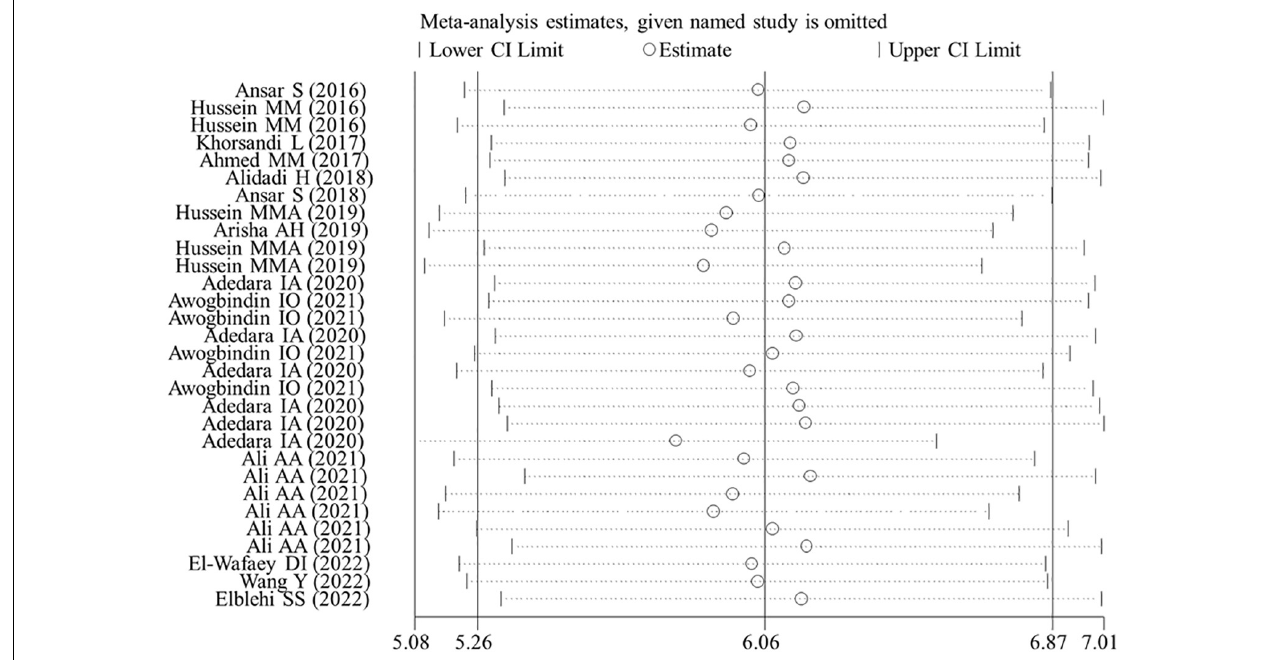
FIGURE 9 | Sensitivity analysis for SOD. CI, confidence